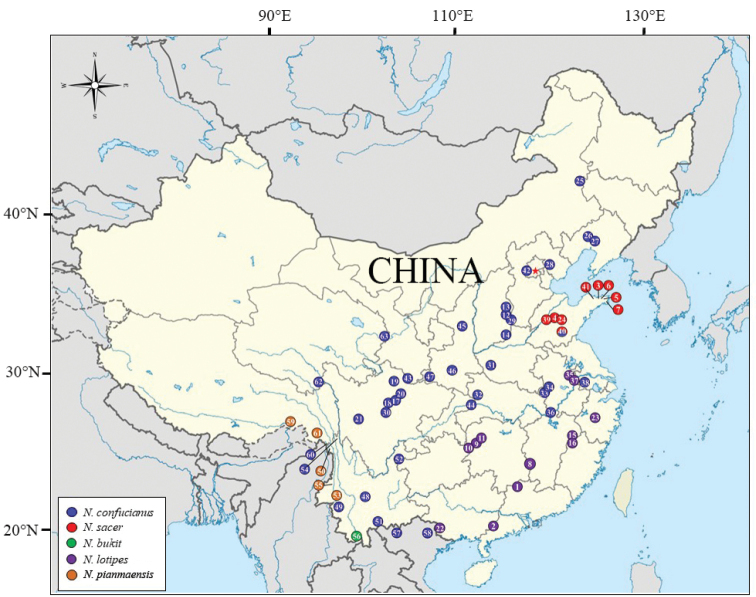
Distribution of phylogenetic clades of N.
confucianus species complex obtained from Cytb. The numbers correspond to the locality code in Suppl. material 1, Table S1.